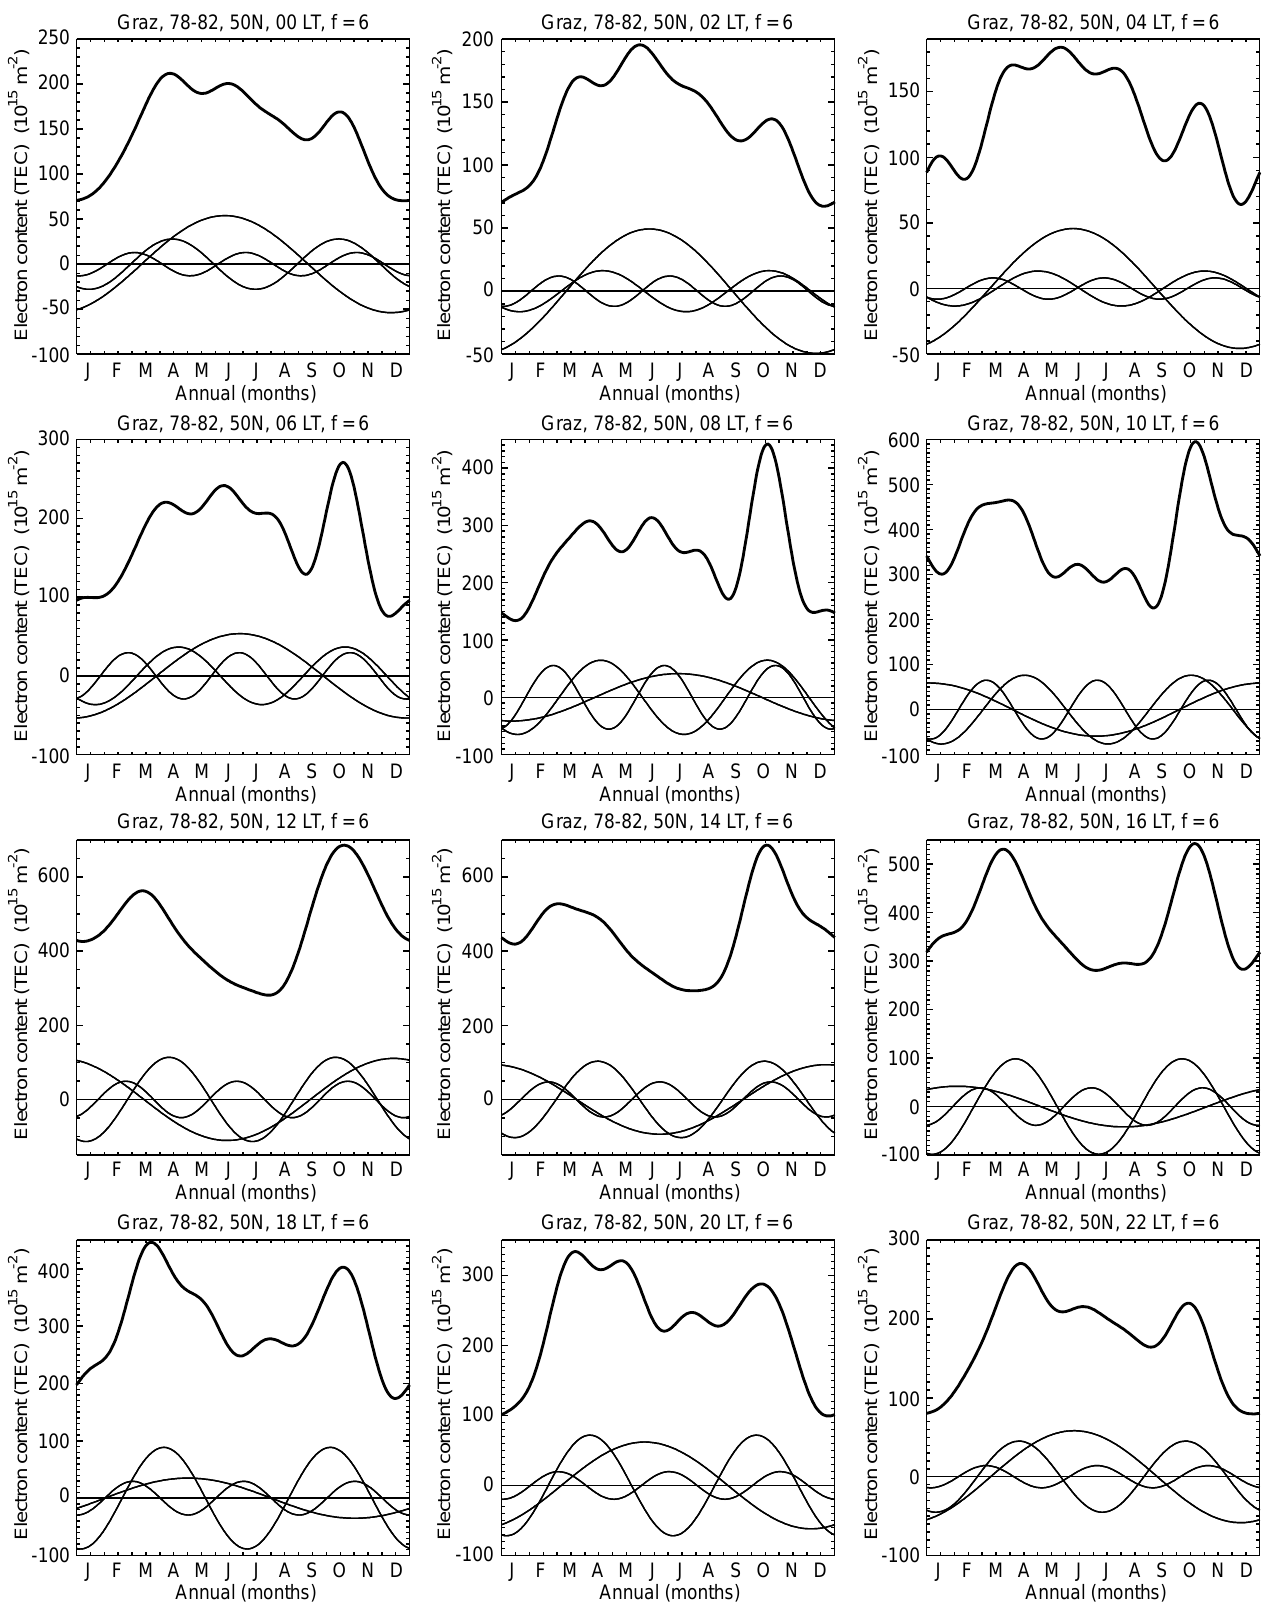
( R (cid:136) 150), solar cycle 21, LT from 00 to 22 h. The first four Fourier components are shown. Based on bi-hourly monthly medians from months selected according to the solar